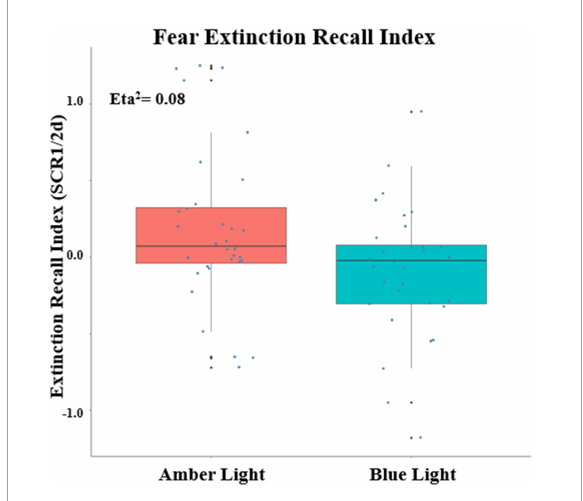
FIGURE4 Fear Extinction Index (ERI) calculated from the differential SCRs during the first two trials of the CS + E minus the first two trials of the CS + U during the extinction memory recall test, Positive values indicate greater recall as measured by Skin Conductance Response (SCR) at post-treatment. The upper and lower "hinges" correspond to the first and third quartiles (the 25th and 75th percentiles) and lines correspond the median value. SCR1/2d: differential